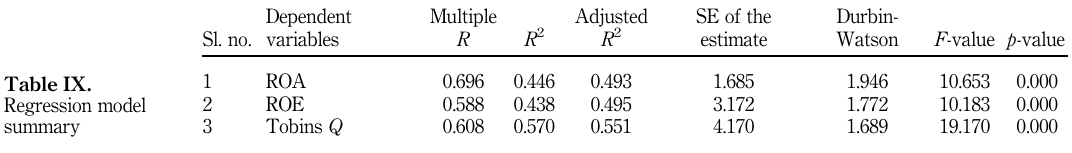
Table VIII. Variance inflation factor (VIF) of the explanatory variables